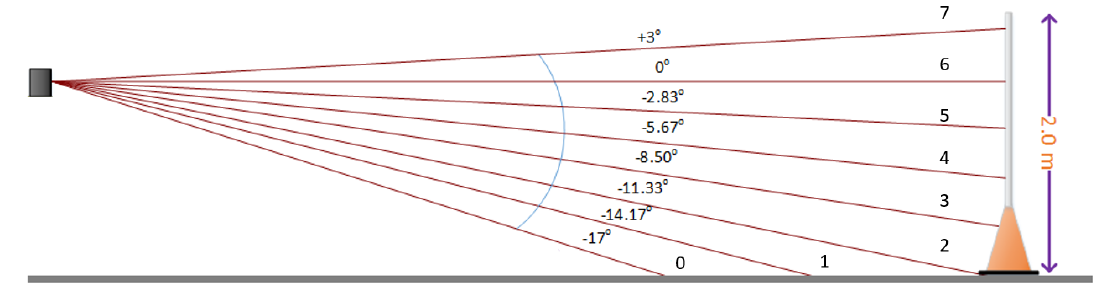
Figure 9. LiDAR beam spacing visualization and beam numbering. The LiDAR is the small black box on the left. Beam 6 is the horizontal beam (assuming the LiDAR is level).